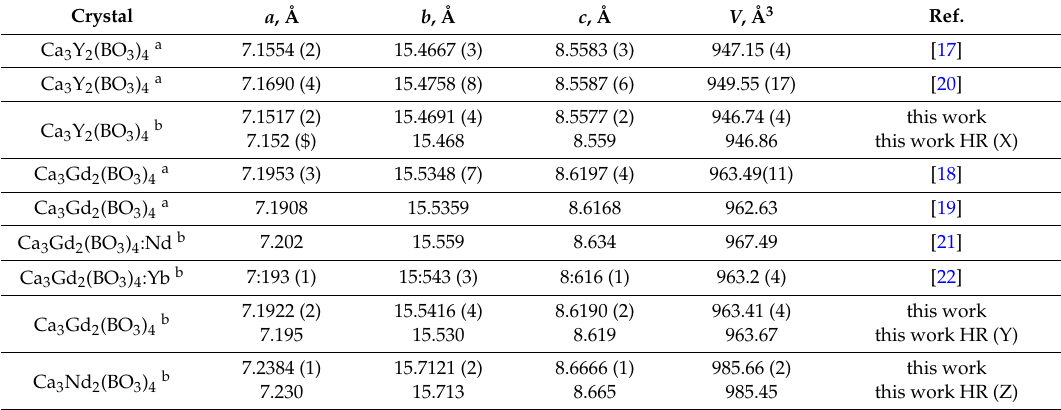
Table 1. Unit cell parameters of Ca 3 RE 2 (BO 3 ) 4 (RE = Y, Gd, Nd) crystals derived from powder and high-resolution (HR) XRD. The values obtained from high-resolution diffraction are given in italics; these values generally agree with those obtained from the powder diffraction; several discrepancies are attributed to the peak shifts occurring for strongly asymmetric reflections.